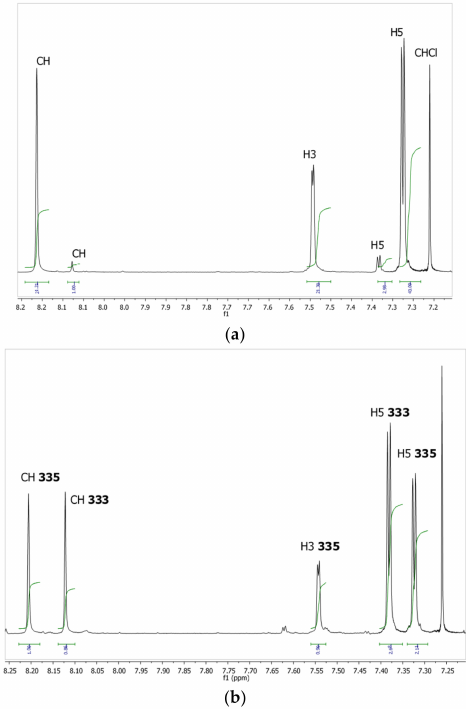
Figure 4. Evolution of the 333/335 ratio with time. ( a ) Recorded after 1 h in CDCl 3 , about 95% of 335 isomer and 5% of 333 isomer; ( b ) recorded after one night in CDCl 3 , about 50/50 of 335 and 333